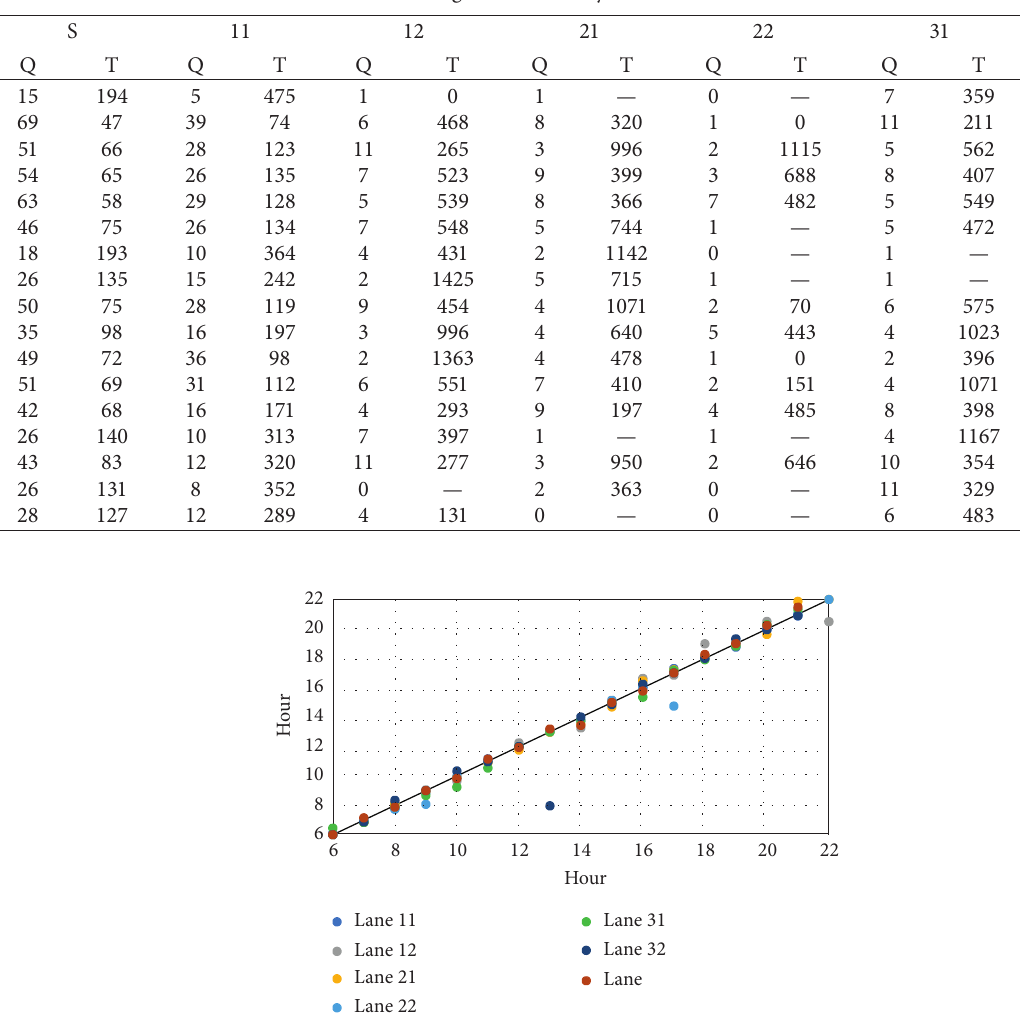
Table 3: Vehicle volume and average time headway from downstream on December 2, 2015.